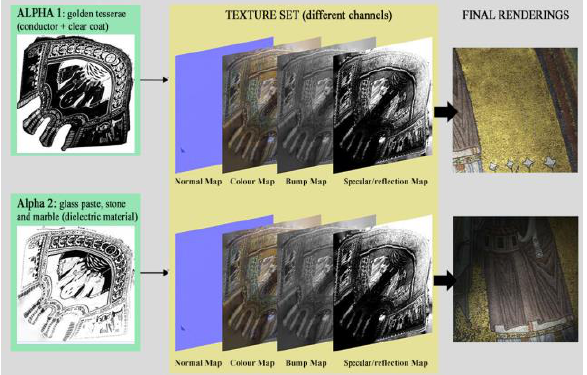
Figure 14. BRDF definition of the apse at San Vitale: stratification of textures, as well as specific shaders applied by means of alpha images.